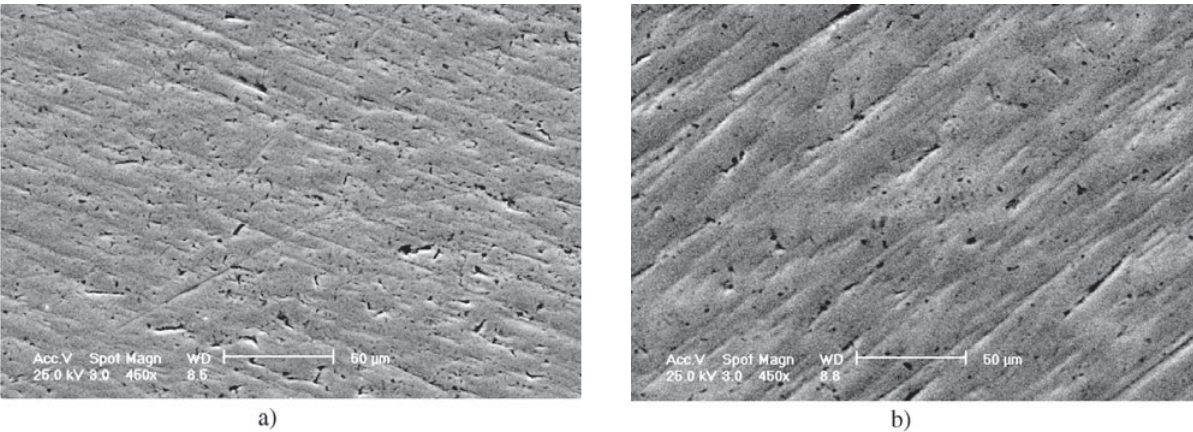
Figure 1. SEM photomicrographs under 450× magnification of (a) c.p. Ti; (b) nitrided sample.